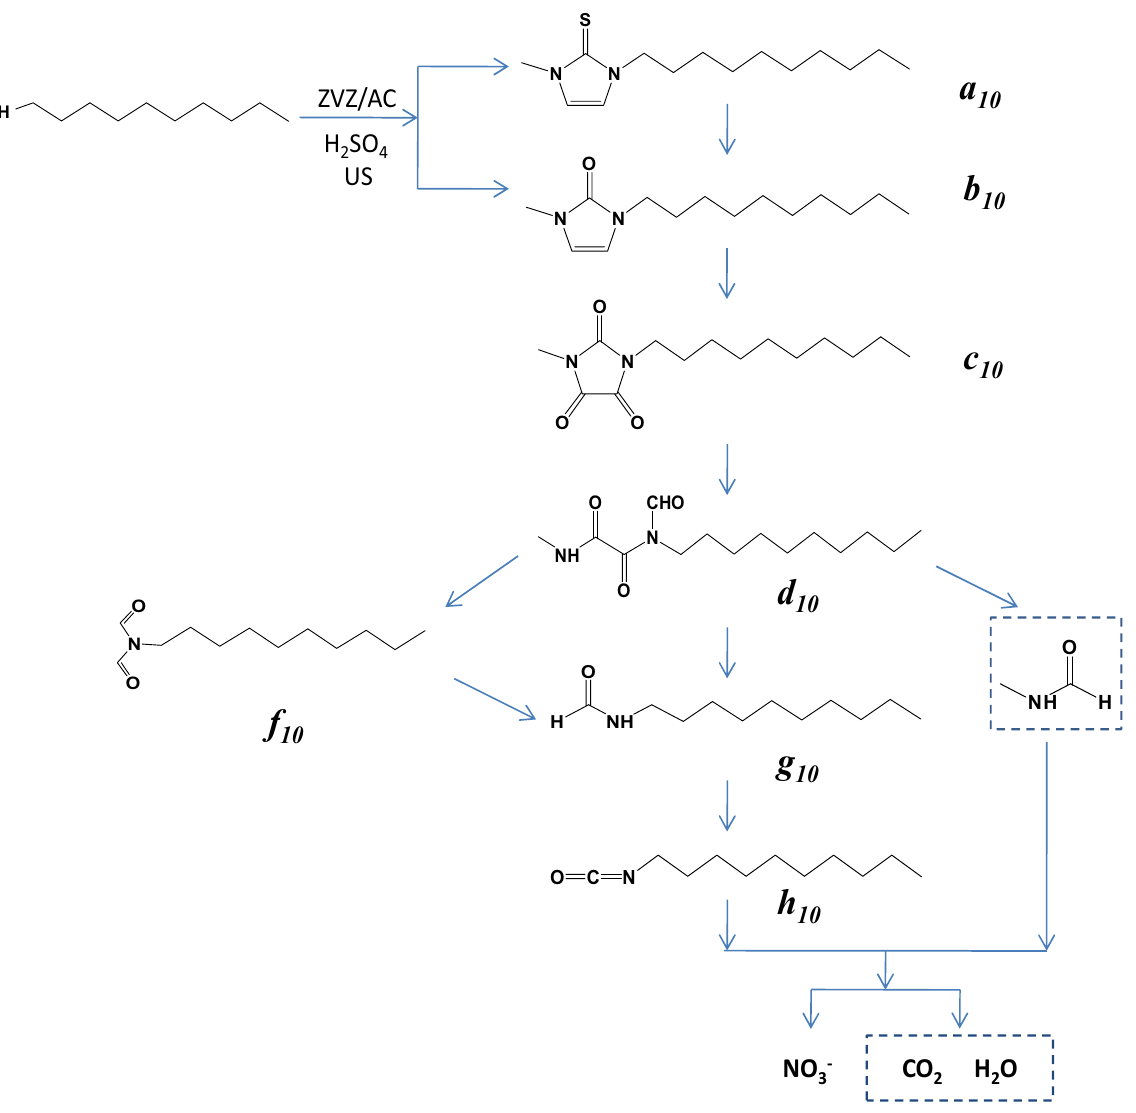
Figure 8. Degradation pathway suggested for [C 10 mim] +